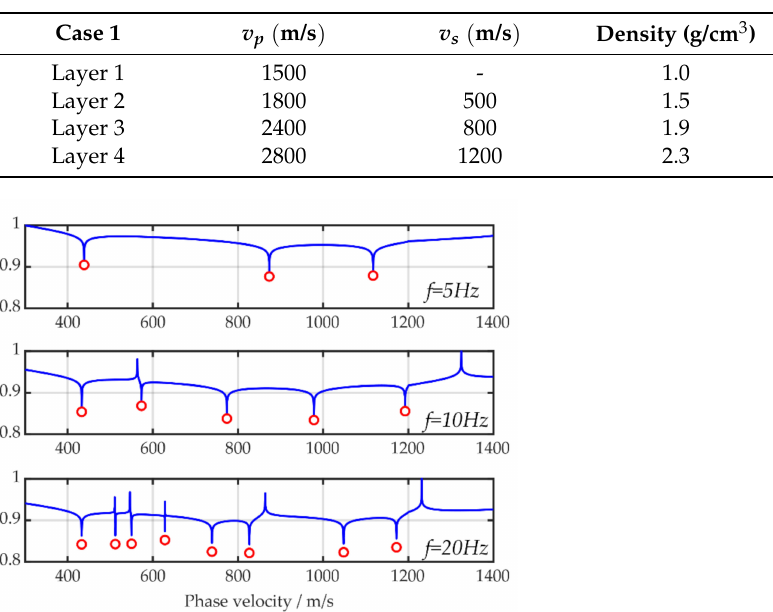
Table 1. Parameters of layered ocean Model 1.